Question: What does this figure show? Answer in one sentence.
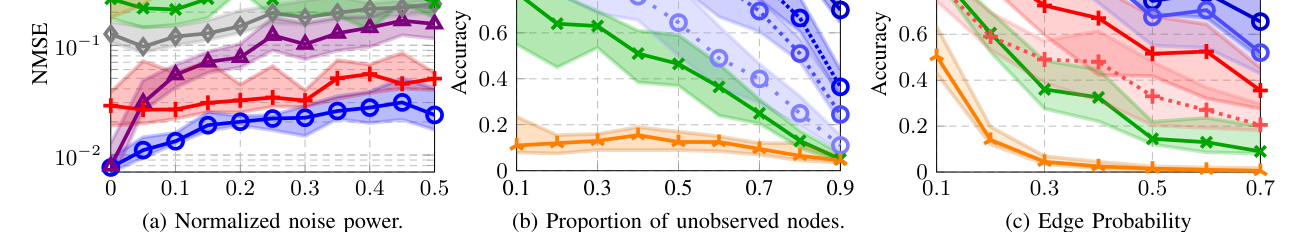
Answer: (a) reports the MNSE in the network diffusion task as the noise in the observations increases; For the source identification task, (b) and (c) depict the influence of increasing respectively the proportion of unobserved nodes and the edge probability. We report the median performance across 25 realizations and values between the first and third quartile in the shaded area.